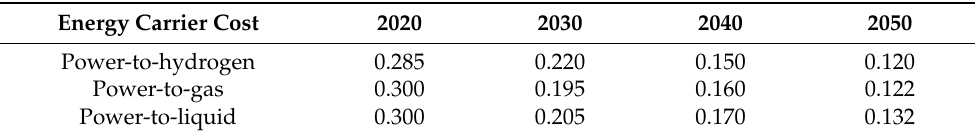
Table 2. Energy carrier cost for electricity-based fuels ( € /kWh). All costs include transport and infrastructure cost.